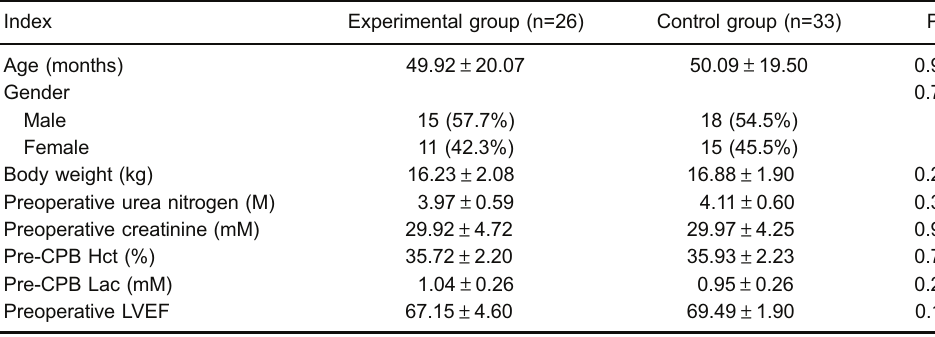
Table 1. General information of